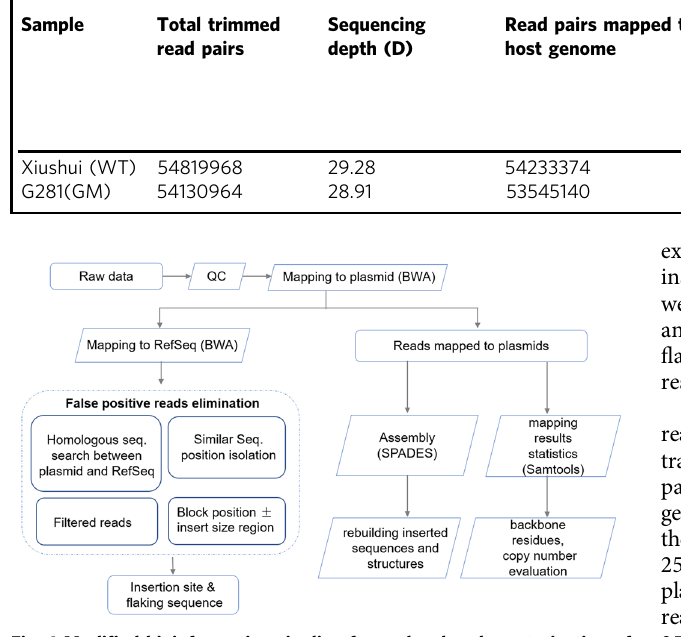
Fig. 1 Modi fi ed bioinformatics pipeline for molecular characterization of transgenic plants using the PE-WGS approach. QC means quality control to obtain the clean sequencing data from raw data, includes steps of removing adapters, low-quality sequences, and contaminated sequences. The Dotted box shows the procedure for eliminating the reads from native genome